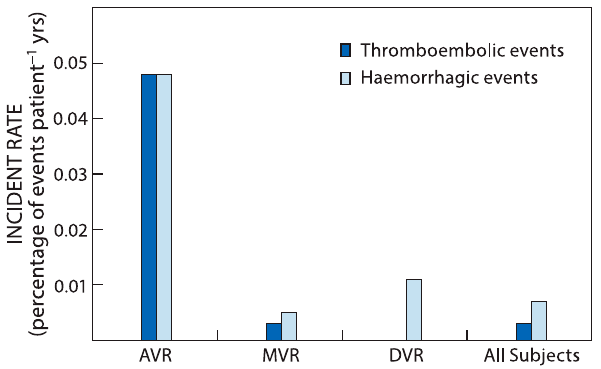
Figure 1: Incident rates of the total thromboembolic and haemorrhagic complications among the different study groups.